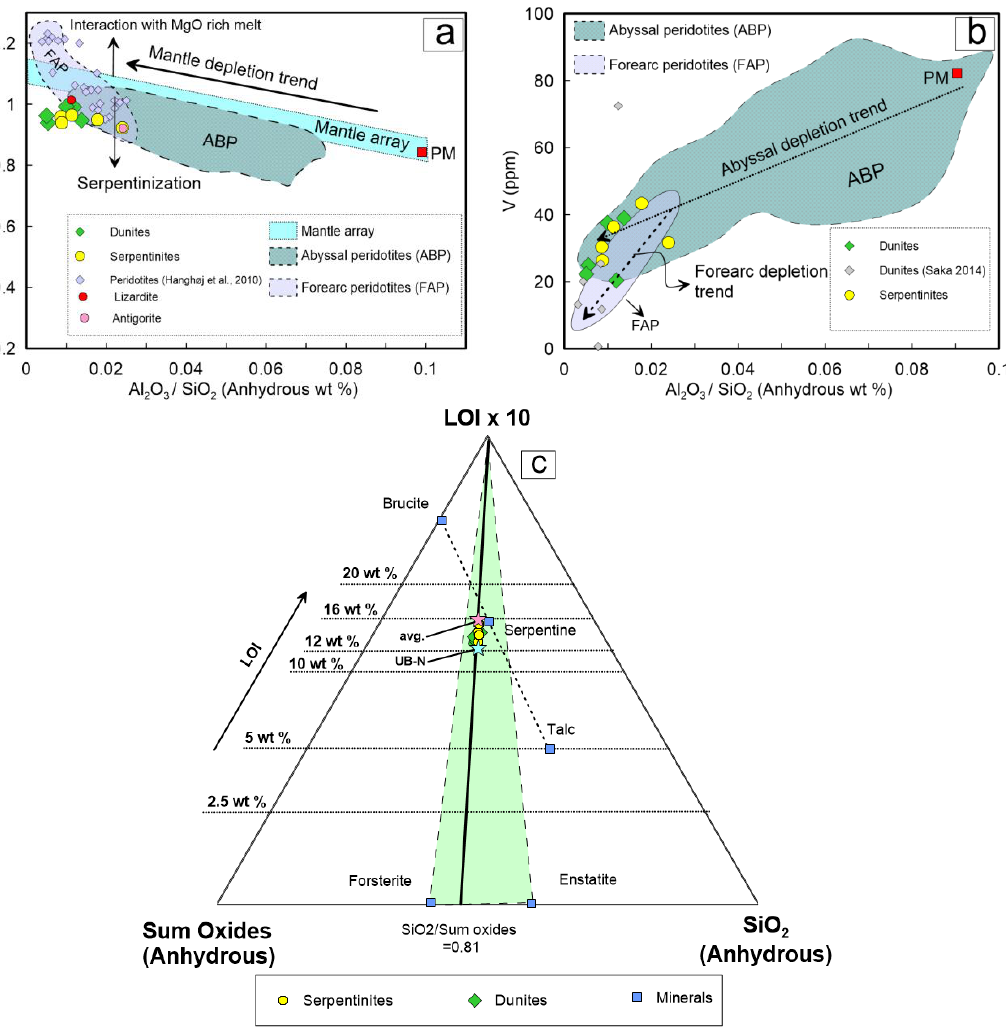
Figure 11. ( a ) SiO 2 normalized bulk rock Al 2 O 3 vs MgO diagram of peridotites from WOC; ( b ) SiO 2 normalized Al 2 O 3 contents plotted against immobile V (ppm). Grey colored samples are overlayed for comparison from Saka et al. [107]. The data for fore-arc peridotites (FAP) are from Parkinson and Pearce [10] and Lian et al. [108]. Abyssal peridotite fields reflect data from Niu [50] and Niu et al. [83]. Forearc depletion trend is from Snow and Dick [44]. Mantle array is from Jagoutz et al. [97] and Hart and Zindler [98]. Primitive mantle values are from Sun and McDonough [45] and McDonough et al. [49]; ( c ) Ternary plot of SiO 2 , sum oxides (MgO + Fe 2 O 3 + Al 2 O 3 + TiO 2